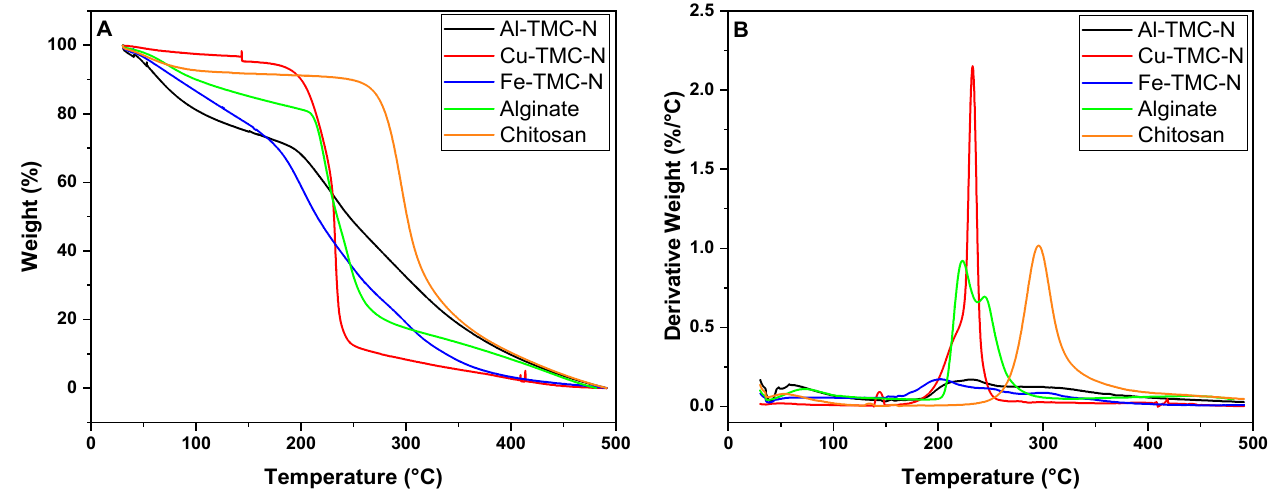
Figure 3. Thermogravimetric analysis ( A ) and derivative thermogravimetric analysis ( B ) of precursor biopolymers and TMCs: Al-TMC-N, Cu-TMC-N, Fe-TMC-N, alginate and chitosan.